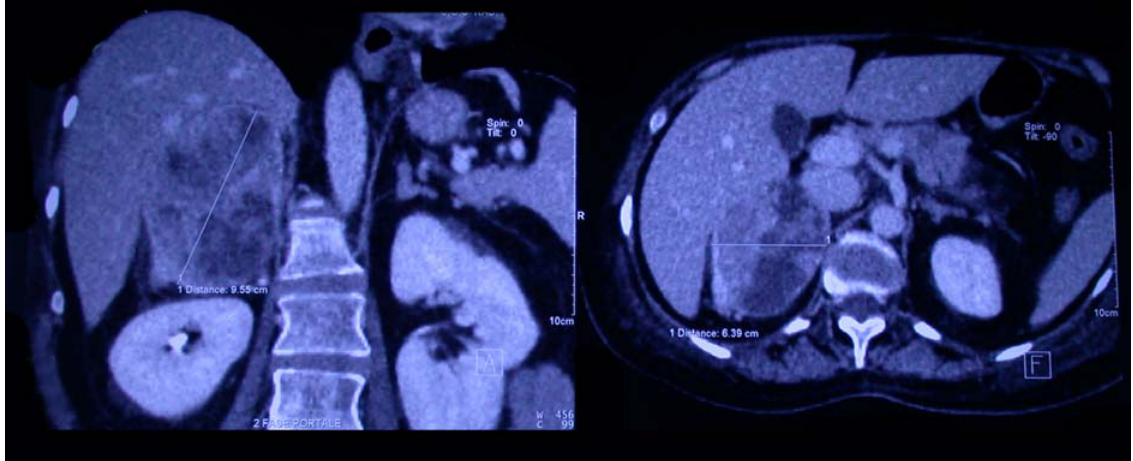
FIGURE 1. CT scan showing a 9.55- × 6.39-cm round mass attached to the right adrenal